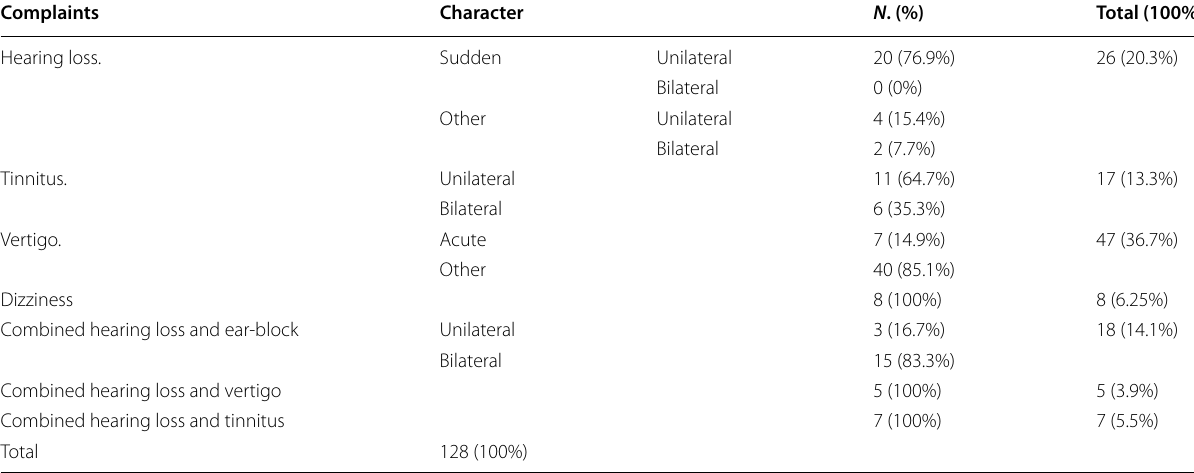
Table 1 Different complaints reported by COVID patients